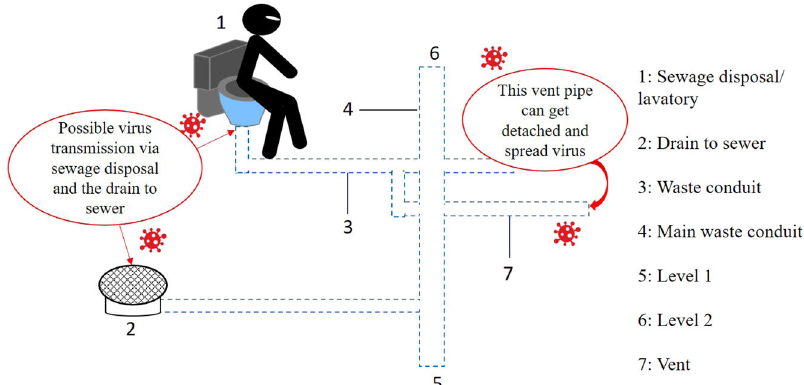
Fig. 2 The possible transmission of coronavirus via faulty plumbing.